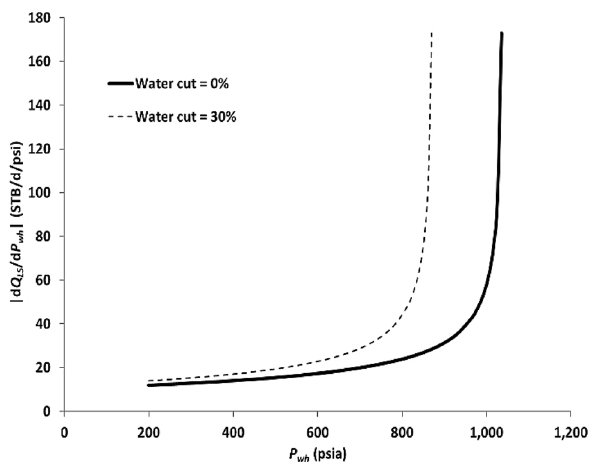
Fig. 11 Stability plots for well A at different water cuts